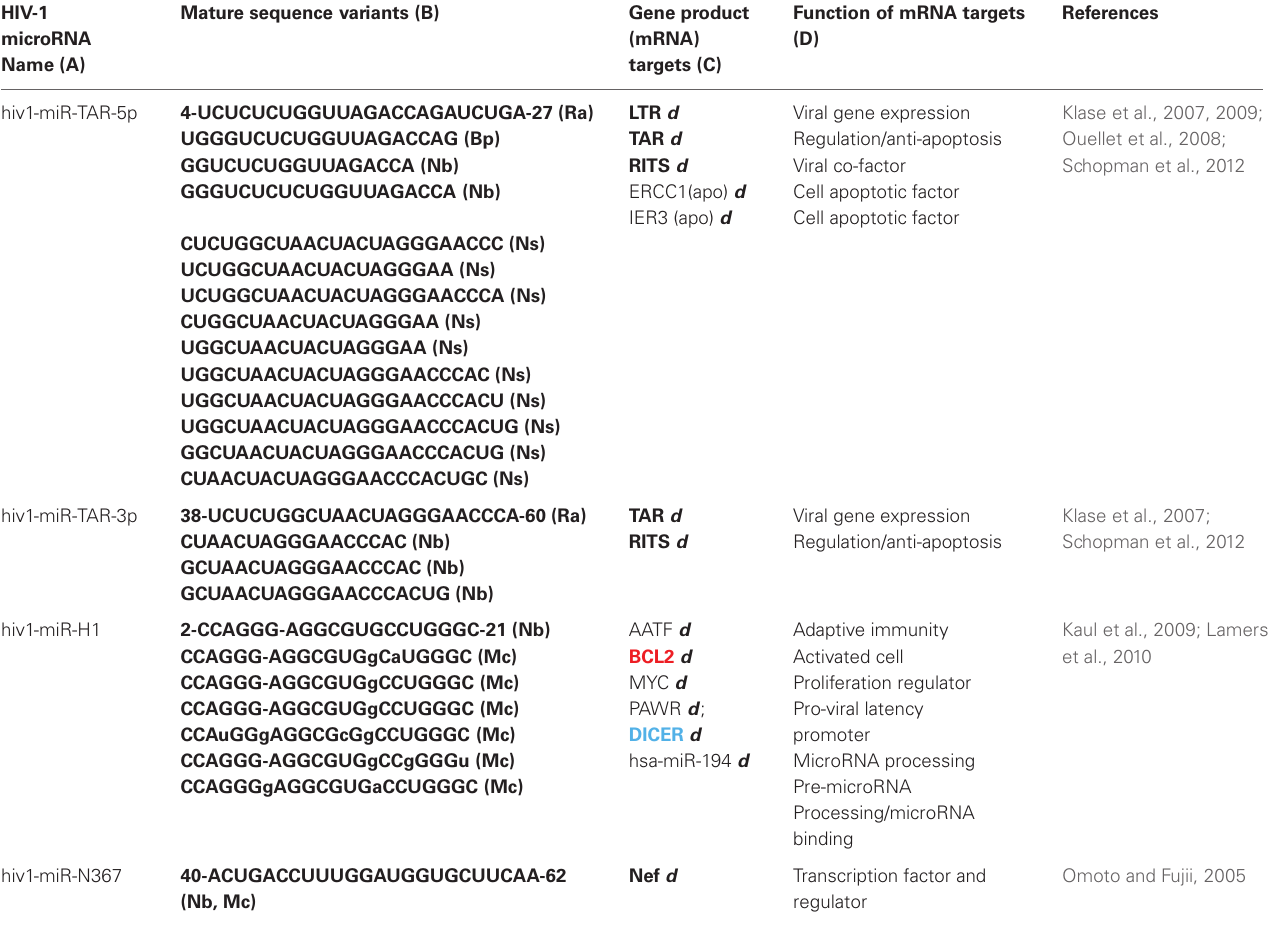
Table 1 | List of published HIV-1 microRNAs and their target HIV-1 and cellular gene products.